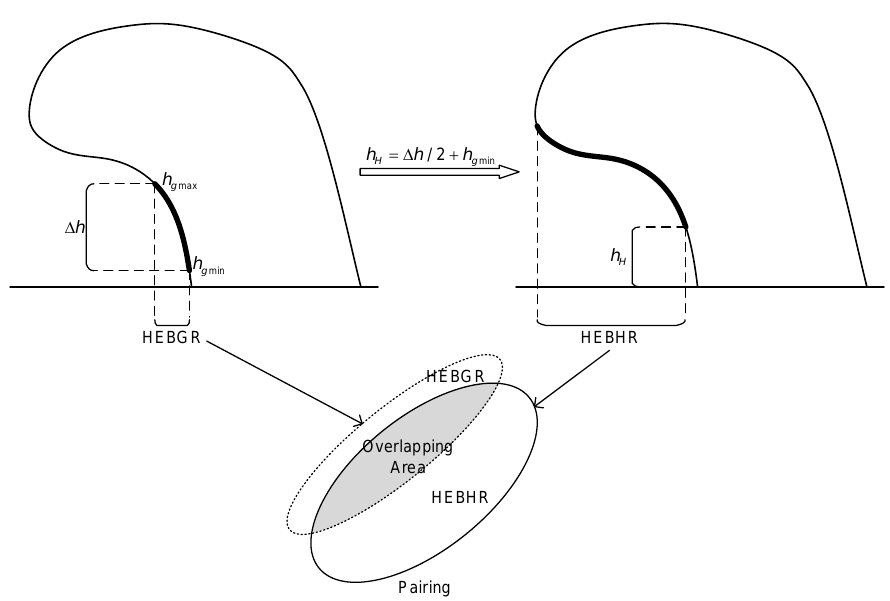
Figure 5. Schematic diagram of the WER detection algorithm. HEBHR, high echo bottom height region; HEBGR, high echo bottom gradient region.